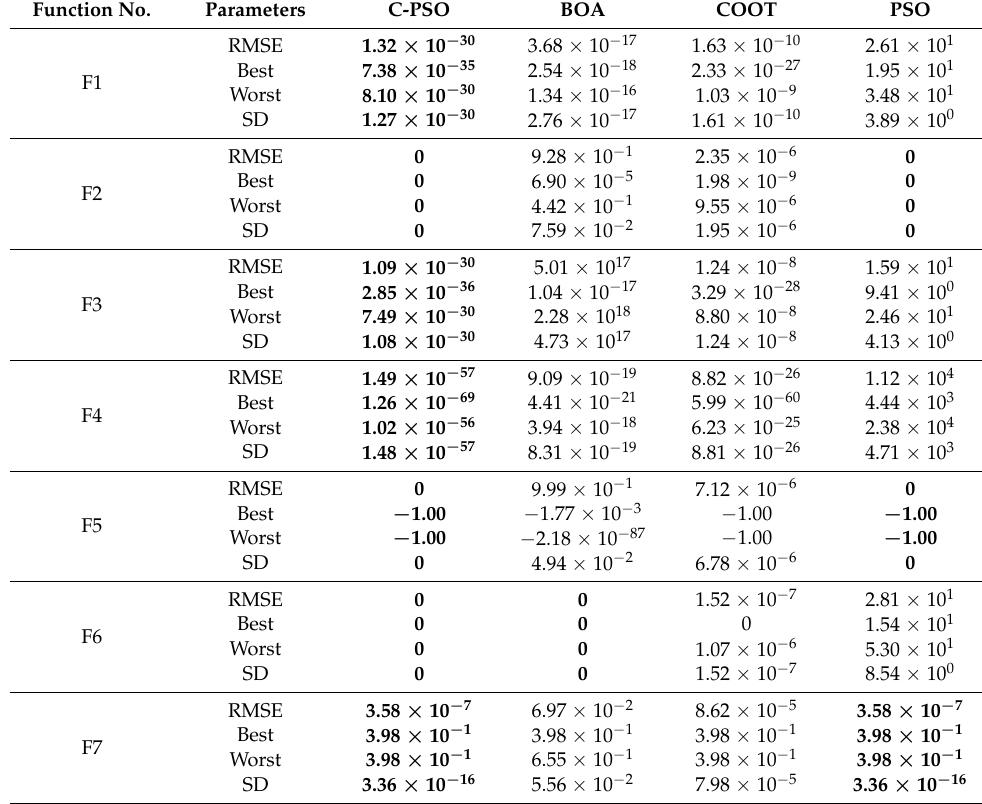
Table 1. Comparative results of executed benchmark functions. Function